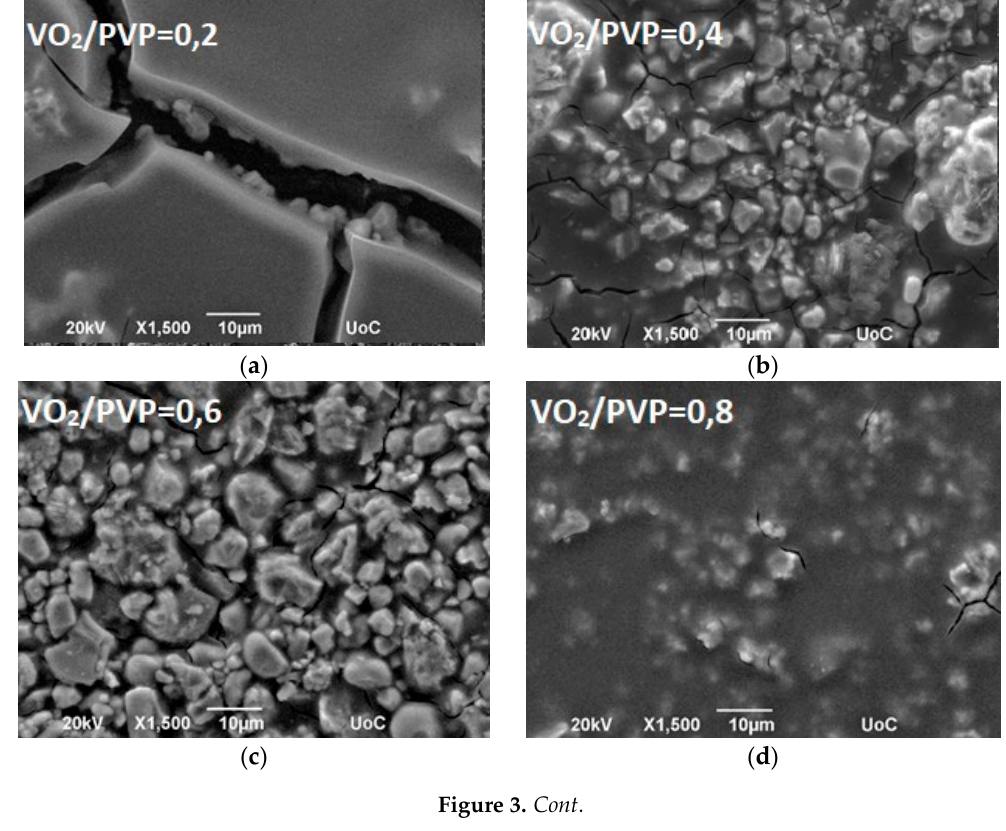
Figure 2. ( a ) XRD pattern and ( b ) image of VO 2 /Poly-Vinyl-Pyrrolidone (PVP) nanocomposite film with ratio VO 2 /PVP = 0.8 deposited on fused silica substrate.